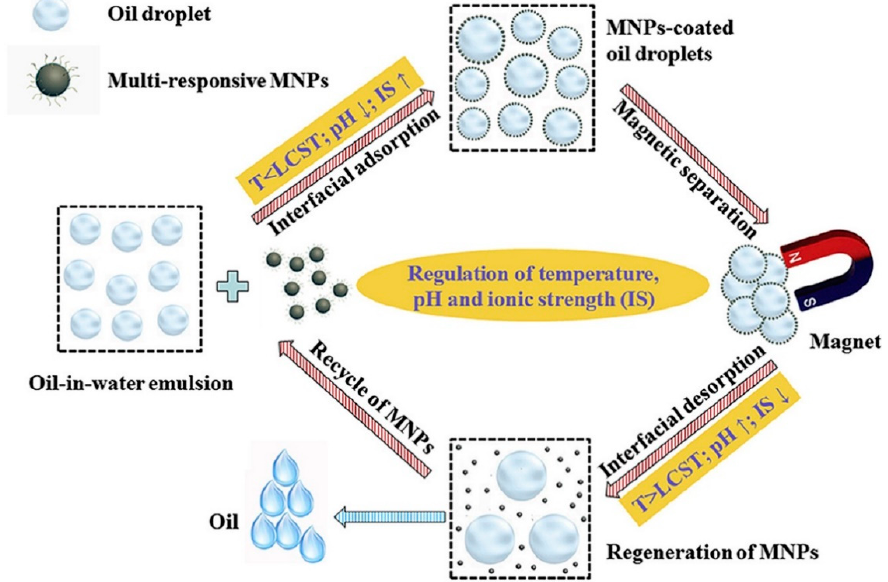
Figure 5. Demulsification of oil in wastewater using magnetic nanoparticles (MNP). Reprinted with permission from ref. [91]. Copyright 2020 Elsevier Ltd. Table 4. Recent development in oily wastewater treatment systems using demulsification methods from 2018 to present. Reference Focus of Research